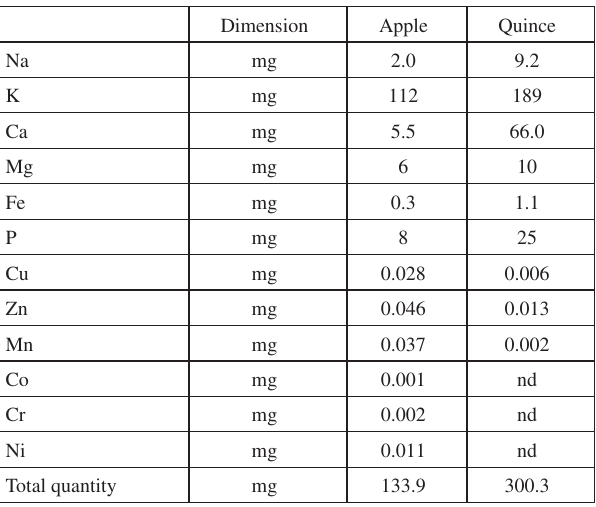
Table 3. Mineral element contents in 100 g quince and apple (‘Jonathan’)